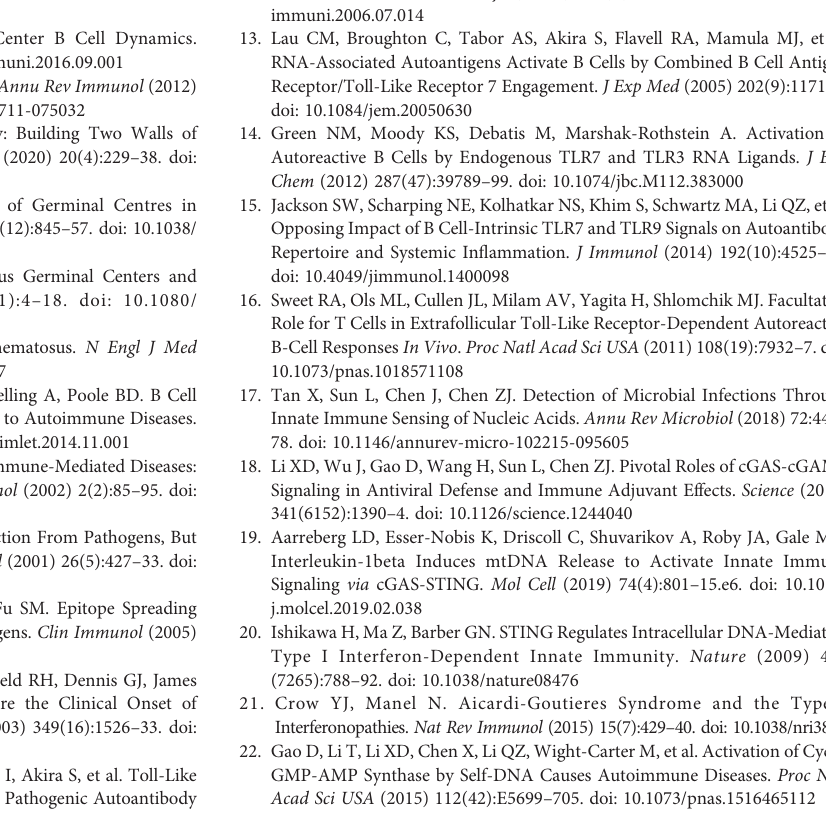
post-test (alpha = 0.05), ns = not signi fi cant, **** = p<0.0001. Supplementary Figure 4 | Assessment of chimerism for the TLR7 mixed BM chimeras and controls. (A) B cell frequencies out of live, singlet lymphocytes, in blood of TLR7-KO (blue, n = 5) and WT (red, n = 5) chimeras. Each dot represents an individual mouse and bars indicate mean +/- SD, with statistical signi fi cance given for unpaired t test ( a = 0.05), ns = not signi fi cant. (B) As in (A) , but for CD4 + T cell frequencies instead. (C) As in (A) , but for CD8 + T cell frequencies instead. (D) CD45.1 pos fraction of CD4 + T cells from (B) , strati fi edfor PA-GFP status. Black bars indicate mean of CD45.1 positive PA-GFP negative cells, whereas pink bars indicatemeanofCD45.1PA-GFPdoublepositivecells.ErrorbarsindicatetheSDof the mean. Dotted lines illustrate expected frequencies of 33.3% and 66.6% on the y-axis. (E) As in (D) , but for CD8 + T cells from (C) instead. (F) As in (D) and (E) but illustrating CD45.1 negative compartments of the CD4 + and CD8 + T cells, respectively. Dotted line illustrates the expected frequency of 33.3% on the y-axis. (G) as for (D) , but for B cells from (A) instead, and with dotted line at the expected frequency of 50% on the y-axis. (H) As (A) , but for 564Igi idiotype (9D11 + ) frequencies of B cells. (I) Anti-dsDNA Ab in blood of TLR7-KO (blue, n = 5) and WT (red, n = 5) chimeras. Each dot represents an individual mouse and bars indicate mean+/-SD,withstatisticalsigni fi cancegivenforunpairedttest( a =0.05),ns=not signi fi cant. Grayed area represents the background level of C57BL6 mice. (J)